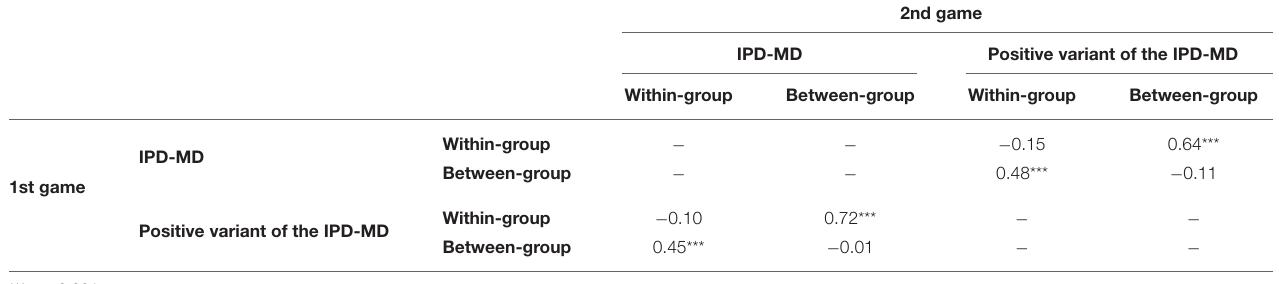
TABLE 2 | Correlations between contribution decisions in the first and second games.